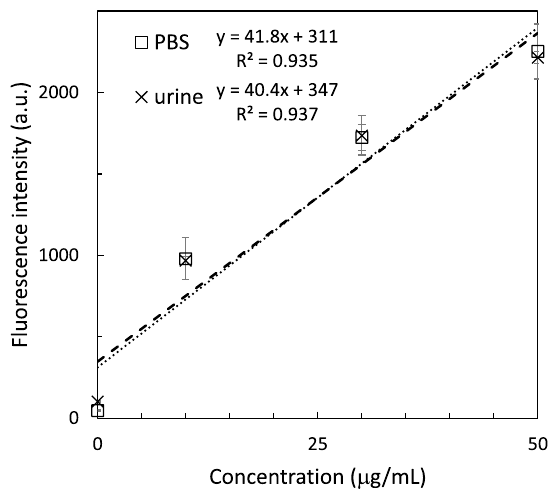
Fig. 4 Calibration curve for VCM in PBS and urine solution with VCM concentrations from 0 to 50 μg/mL. Square and cross indicates PBS and urine, respectively. Error bars represent CV of three measurements